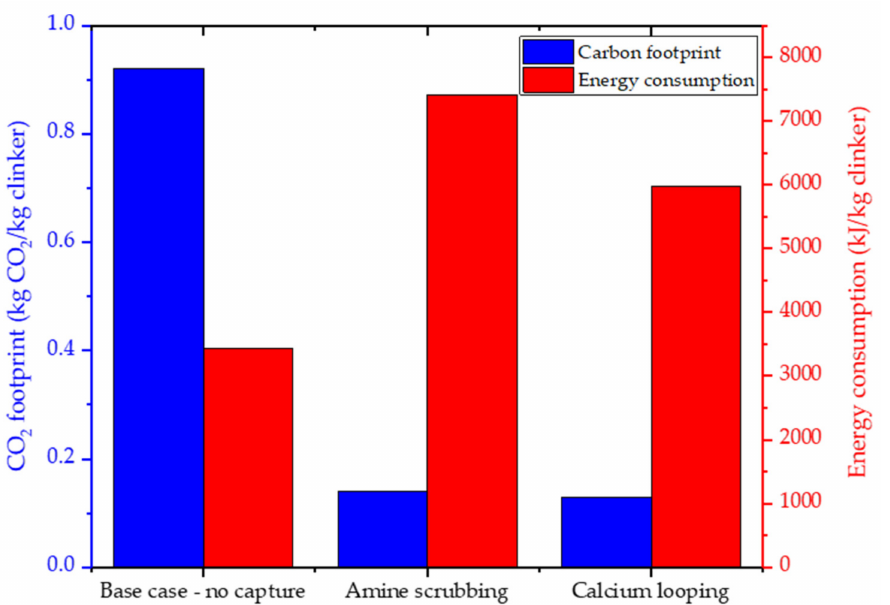
Figure 2. Efficiency analysis between CO 2 -capturing technologies. Reprinted with permission from ref. [16]. Copyright 2021